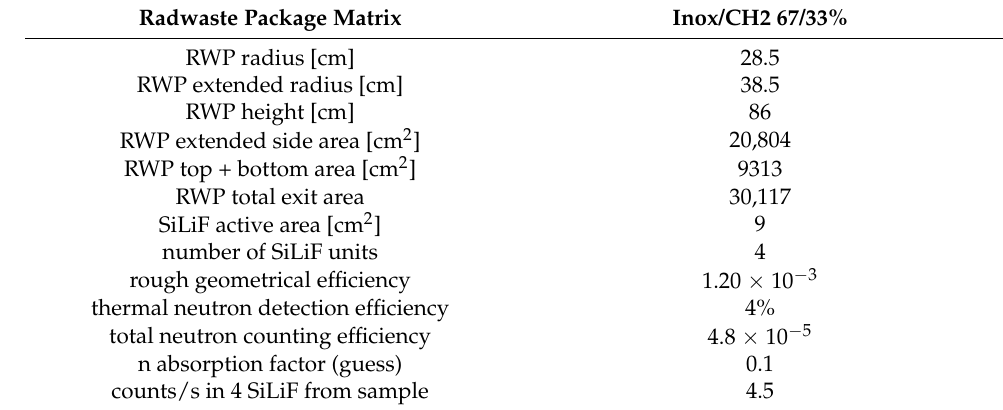
Table 3. Rough estimate of the total expected neutron rate on the four silicon detectors, considering a uniform output flux from the radioactive waste package (RWP) cylinder surface, a 10% neutron absorption inside the drum and fully thermalized neutrons reaching the 6 LiF